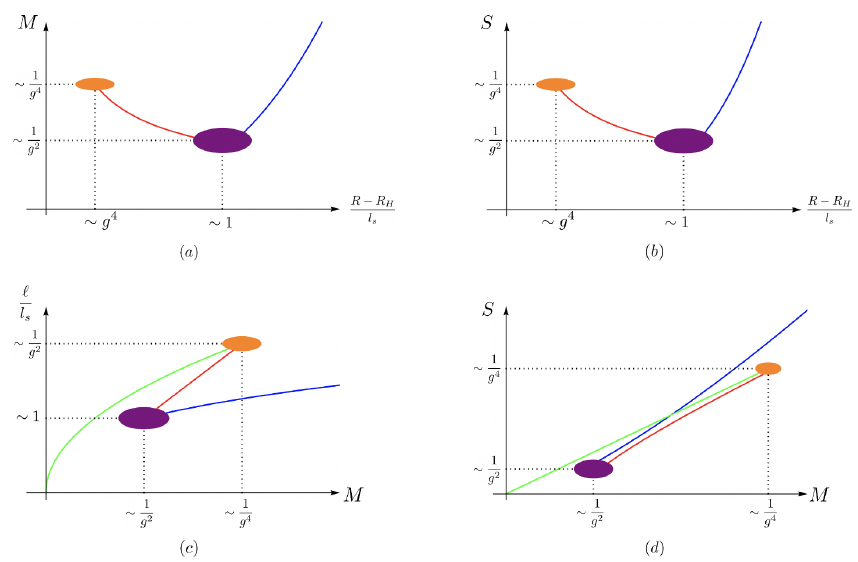
Figure 7 . The phase diagrams for d = 5 . In the plots, the blue, red, green lines represent the black hole, Horowitz-Polchinski solution and free strings, respectively. The orange and purple blobs denote the transition regions between the